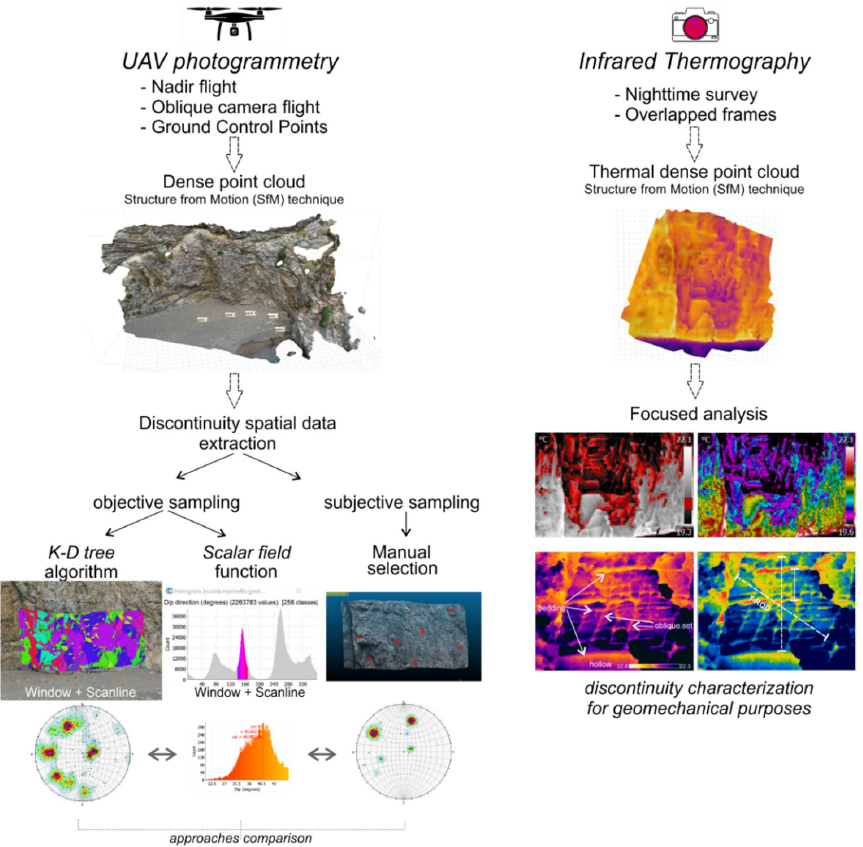
Figure 1. Conceptual map describing the methodological approach of the research. Photogrammetric RGB remote surveys were carried out, in daylight condition, using a Parrot Anafi Thermal quadcopter equipped with a digital sensor 1/2.4‘‘ CMOS (active ‐ pixel sensor) and 21 Mpixel with 26 mm focal length for the photogrammetric part. Tar ‐ gets of 50 cm × 50 cm size were placed as Ground Control Points (GCP), homogeneously distributed in the framed area, for a precise GPS localization and two flight plans were set to guarantee an average overlapping of 70% between contiguous frames. The first one was carried out in nadir conditions by aligning the camera axis with the vertical direction, so